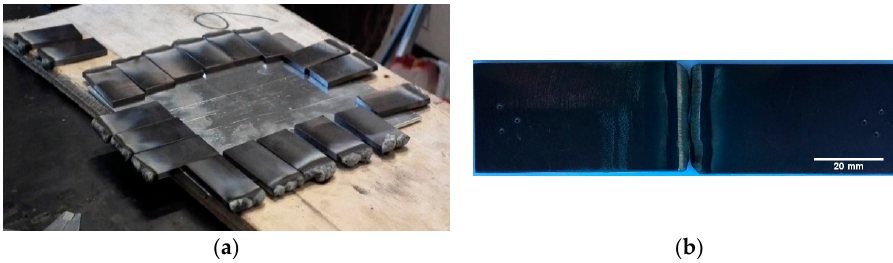
Figure 3. Test specimens after Nickel filler metal deposition: ( a ) welded Nickel bead to chamfer edge; and ( b ) re-chamfered edges after Nickel deposition.